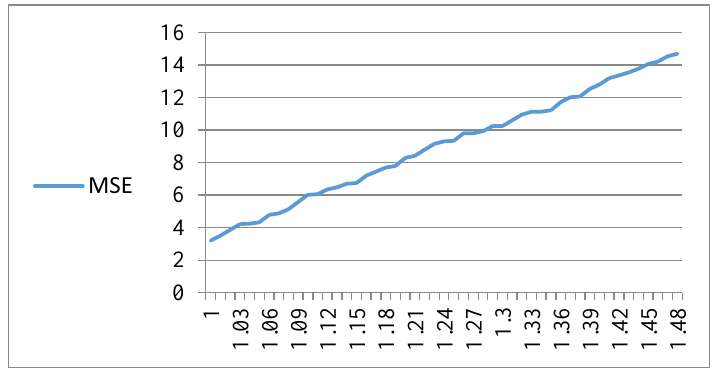
Fig. 2. MSE of Bayesian-estimate with respect to